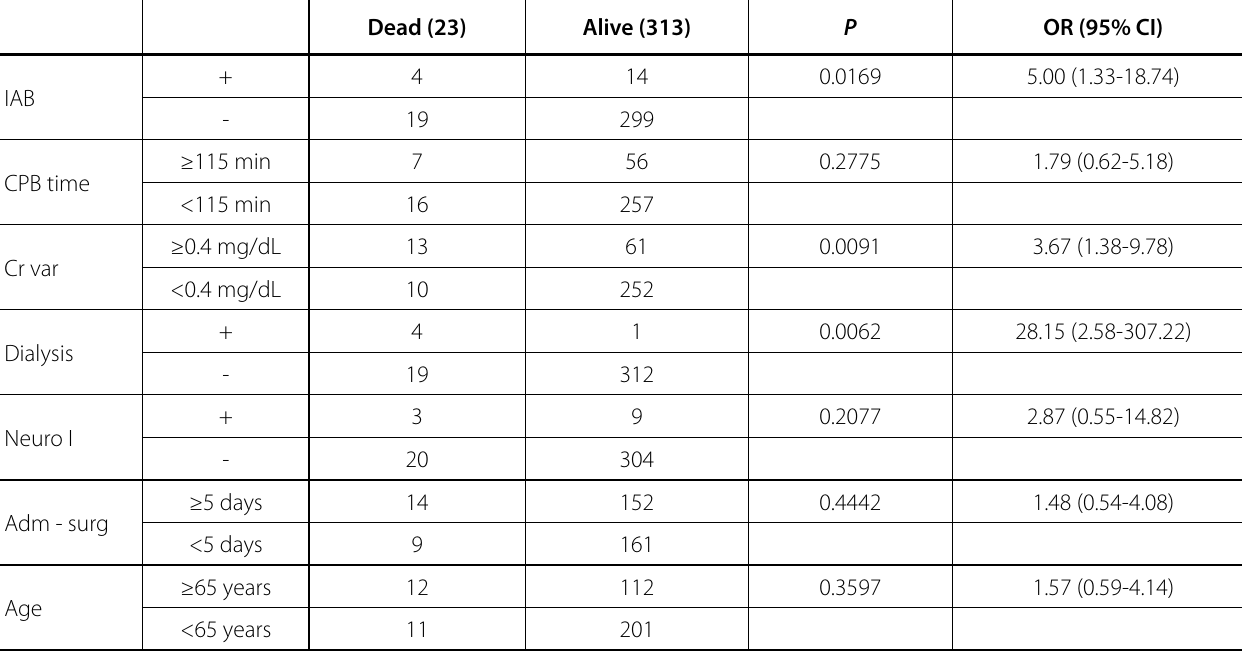
Table 1 . Mortality risk factors among ONCABG patients (n=336) with AC levels greater than or equal to 0.2 and less than 1 mg/dL (QI).